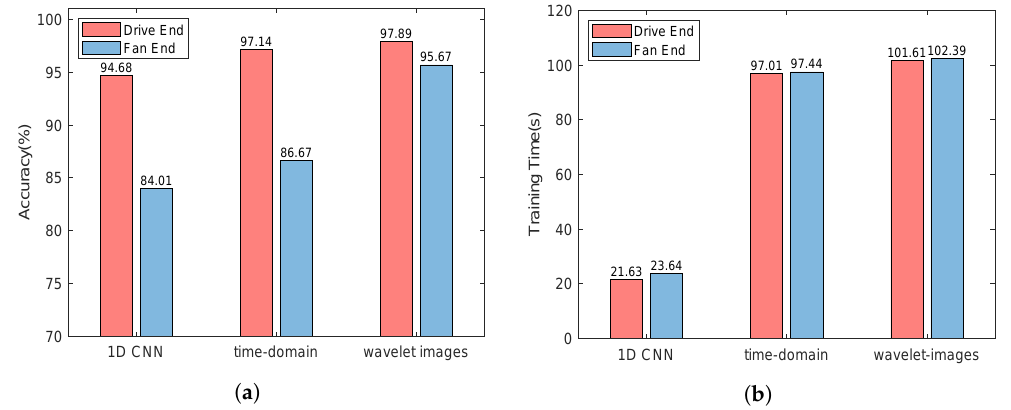
Figure 7. Accuracy and training time